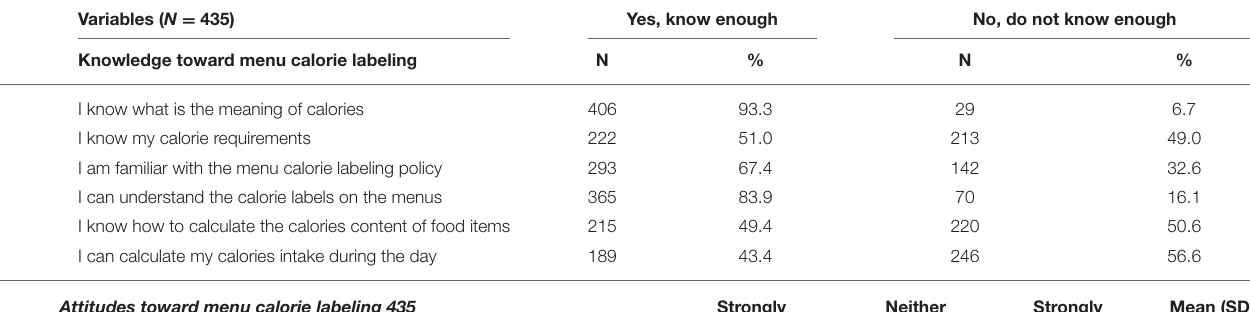
TABLE 2 | Assessment of knowledge, attitudes, and practices of participants toward menu calorie